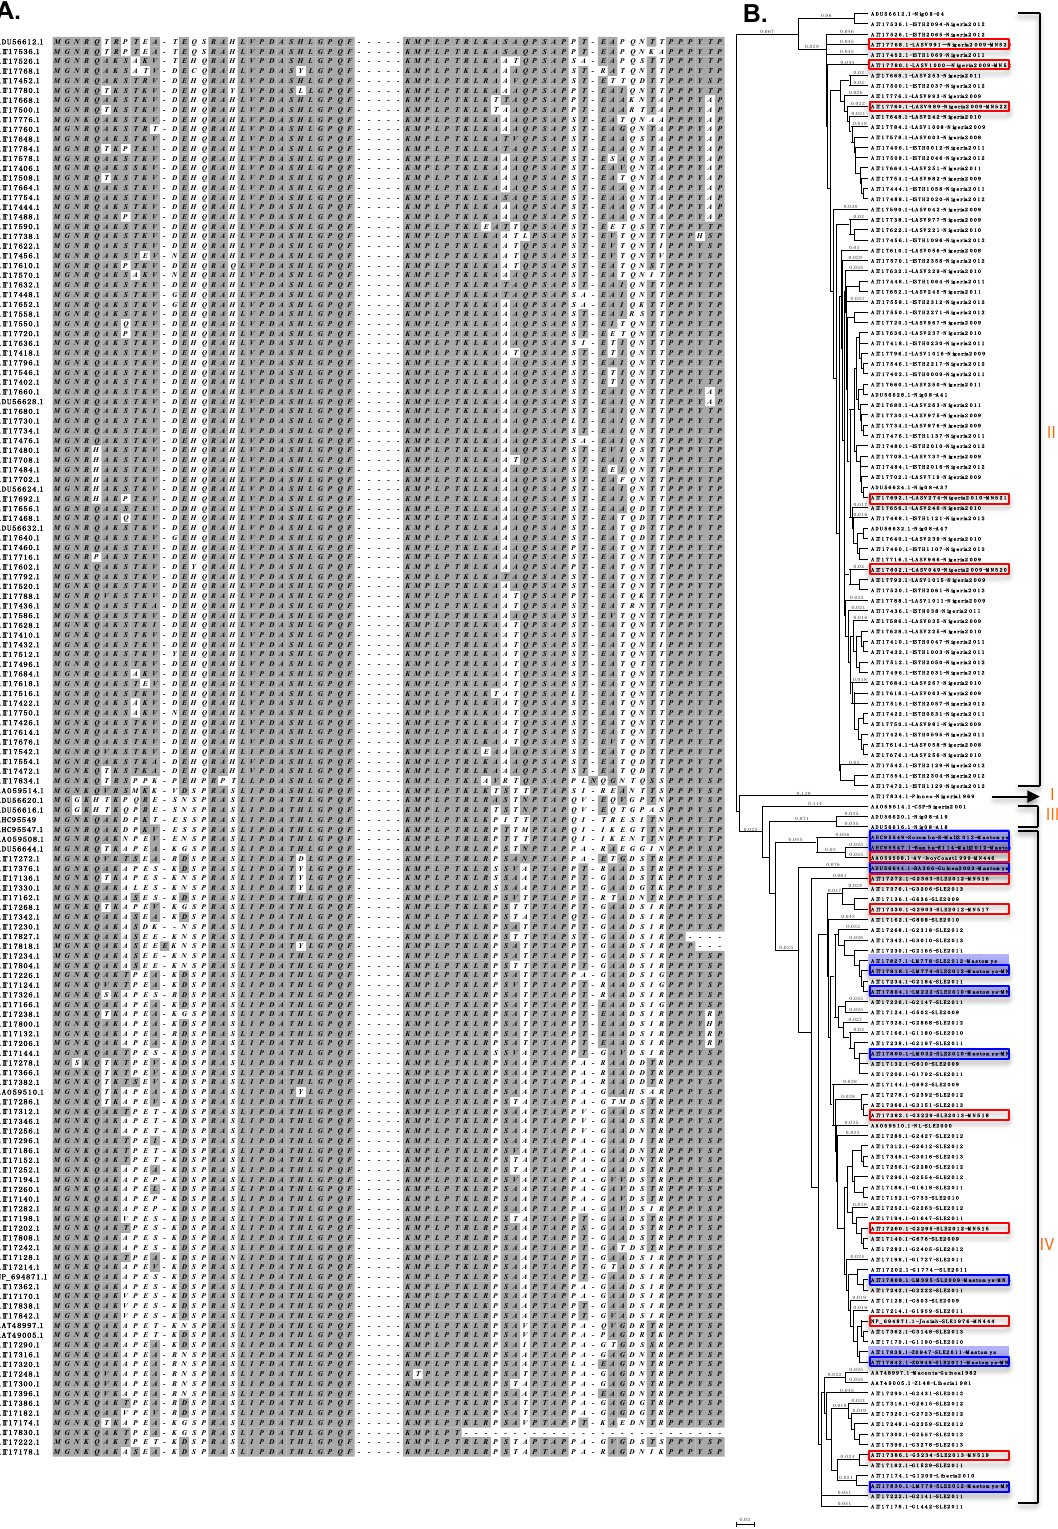
Figure 1. Sequence alignment and phylogenetic analysis of LASV Z proteins. ( A ) The Z protein amino acid sequences obtained from the GenBank database were aligned, with the N-terminal domain (NTD) and the C-terminal domain (CTD) sequences shown. Sequences of the conserved central RING